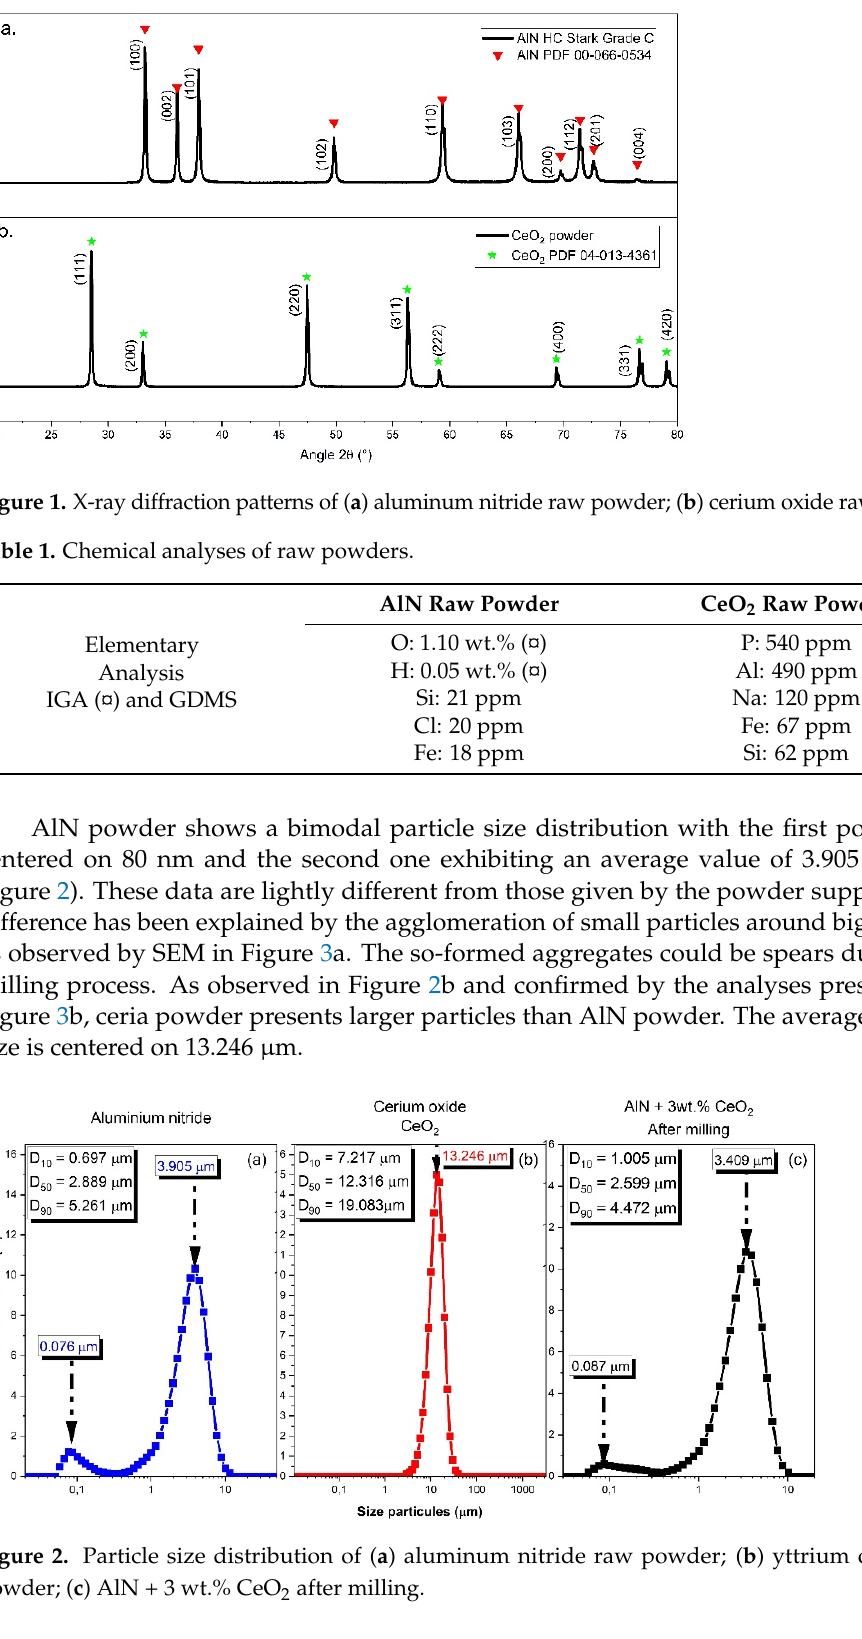
Figure 3. SEM observations of the raw powders. ( a ) Aluminum nitride; ( b ) cerium oxide. The milled samples showed a final granulometry composed of two populations, as represented in Figure 2c. The first one is centered on 3.409 μ m and the second one is cen- tered on 0.087 μ m. The milling process allows one to decrease the grain size of cerium oxide powder and permits one to obtain a homogenized powder composed of AlN and a sintering additive. 3.2. Specific Focus on Aluminium Nitride Powder To delve deeper into the AlN powder analyses, examinations were conducted by transmission electronic microscopy (TEM) to obtain further information on the oxidation detected by IGA. As presented in Figure 4a, a 2–5-nm-thick amorphous layer can be ob- served by TEM and is assumed to be uncrystallized aluminum oxide. Figure 4. TEM observations of an AlN grain. The arrow points to a nanosized-thick amorphous layer. ( a ) AlN particle with amorphous layer, ( b ) AlN particle without amorphous layer.